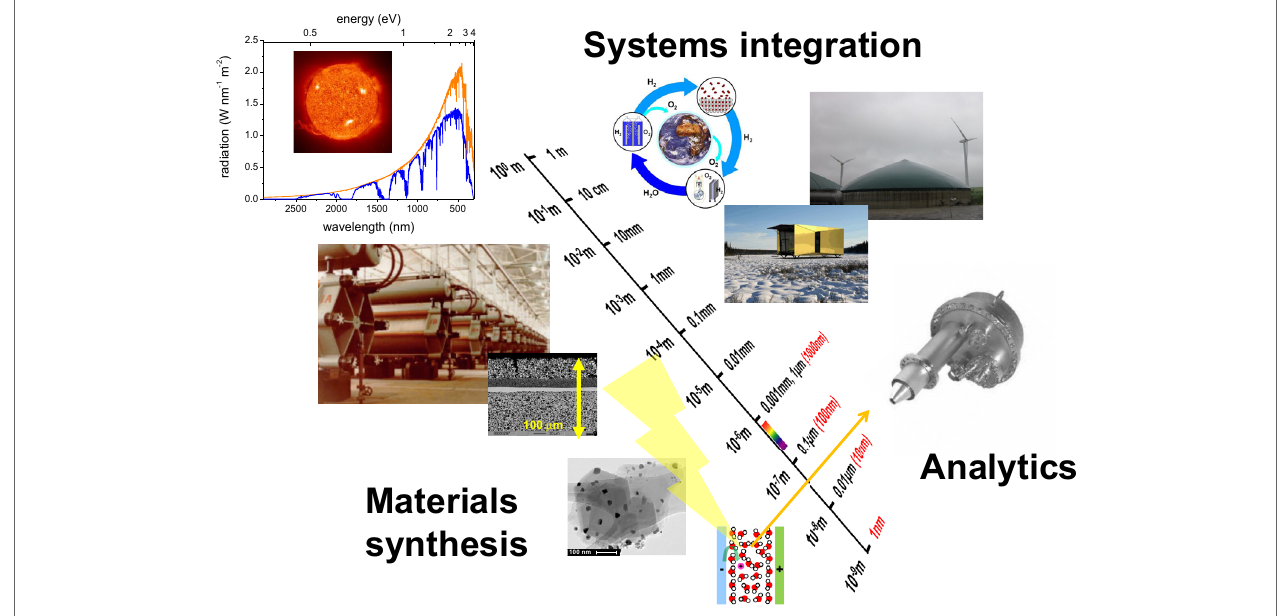
FiGUre 1 | the three hydrogen grand challenges in a nutshell: although at the beginning, the (atomistic) phenomena as characterized by state-of- the art analytics (challenge 1) are utilized by advance materials (challenge 2), which are part of big systems (challenge 3) to store and distribute the energy of the sun . The hydrogen grand challenge comprises research and development from the nano-scale to the macroscopic world. Pictures are from NASA, and references (Züttel et al., 2008; Bielmann et al., 2011; Vogt et al., 2014).